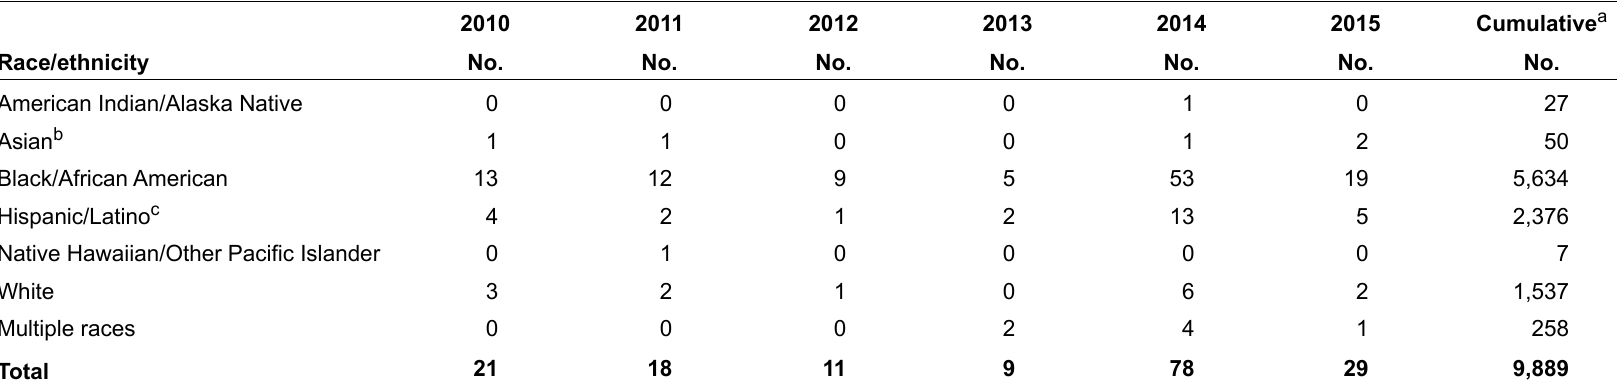
Table 8b. Stage 3 (AIDS) among children aged <13 years, by race/ethnicity, 2010–2015 and cumulative—United States and 6 dependent